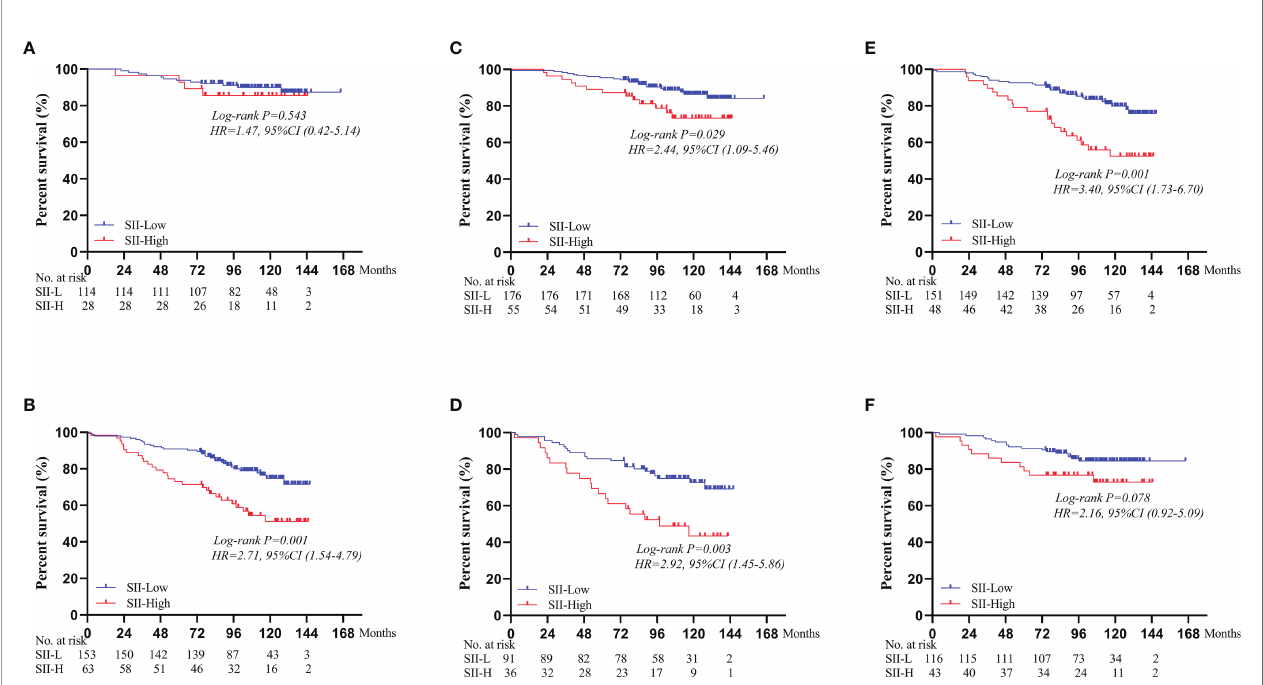
FIGURE 3 | Survival curves of OS comparing SII-L group and SII-H group based on the age, TNM stage, and adjuvant chemotherapy status. (A) In the non-elderly group. (B) In the elderly group. (C) In the stage I group. (D) In the stage II group. (E) In the non-adjuvant group. (F) In the adjuvant group. SII, systemic immune- in fl ammation